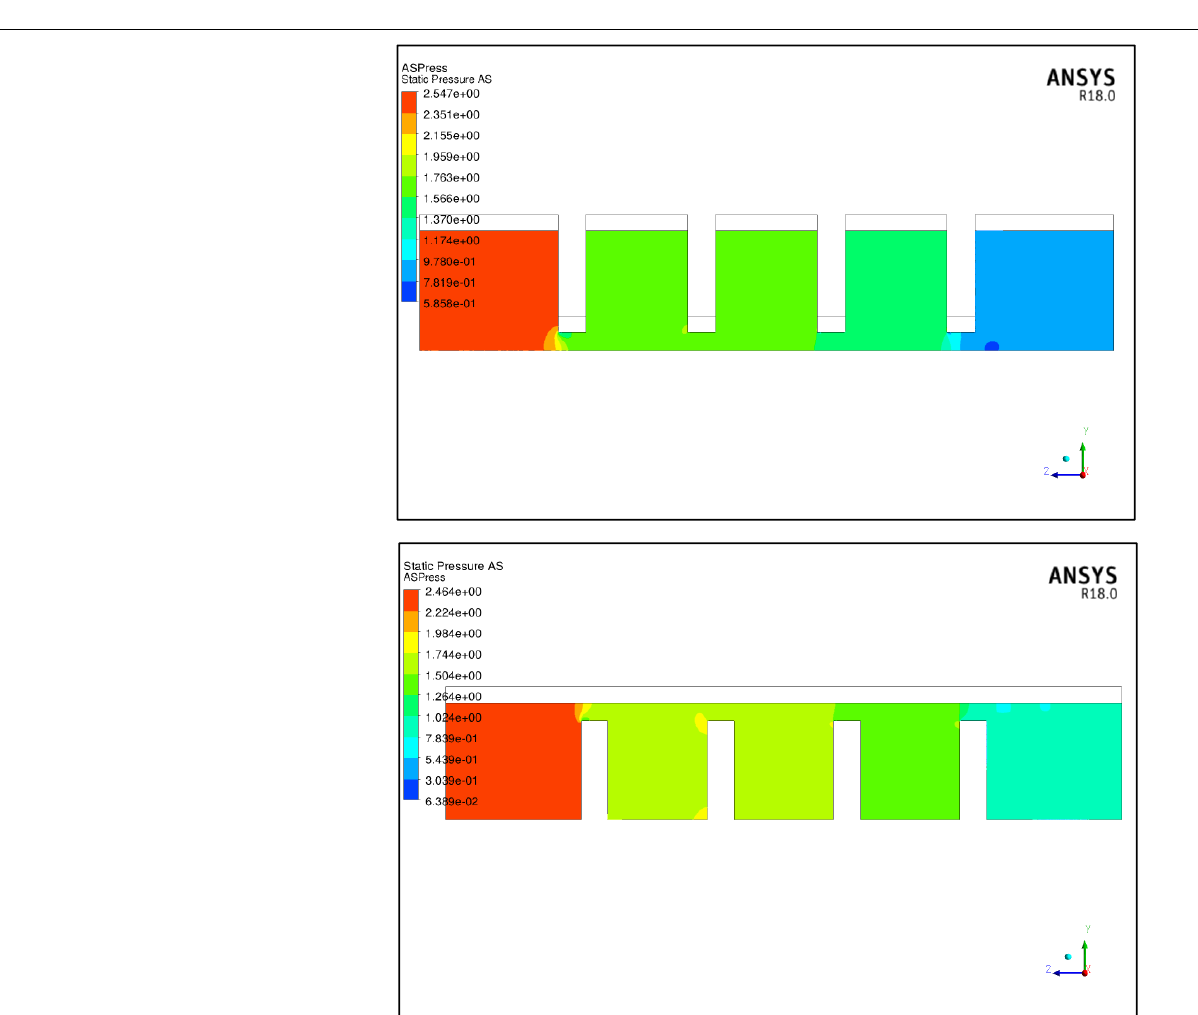
Table A5. Total temperature